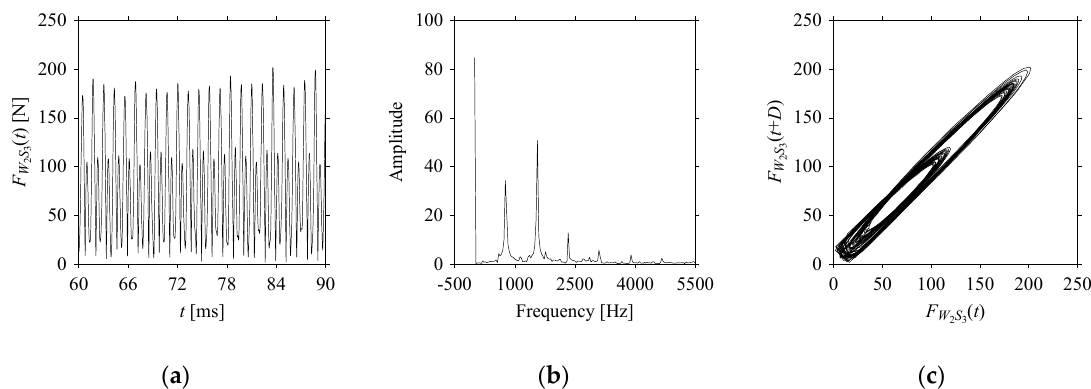
Figure A6. F W in the form of: ( a ) time series, ( b ) fast Fourier Transformation (FFT), and ( c ) delay map ( d = 1). 2 S 3